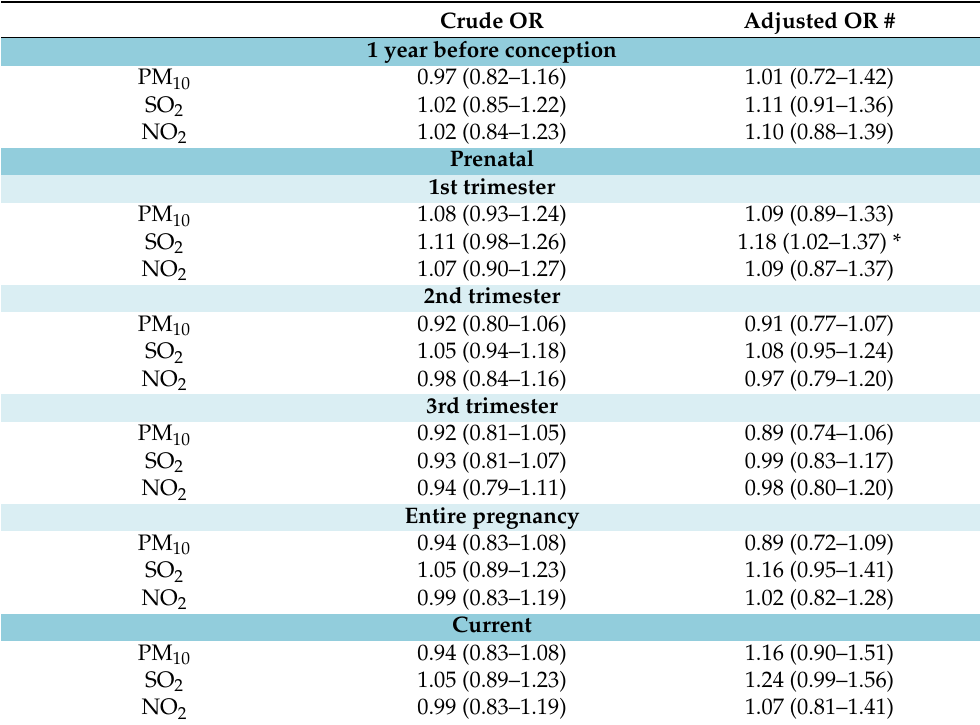
Table 2. Odds ratio (95% CI) of childhood annual SAR to pollen for exposure to outdoor air pollution during 1 year before conception, prenatal, and current periods ( n = 2598). Crude OR Adjusted OR